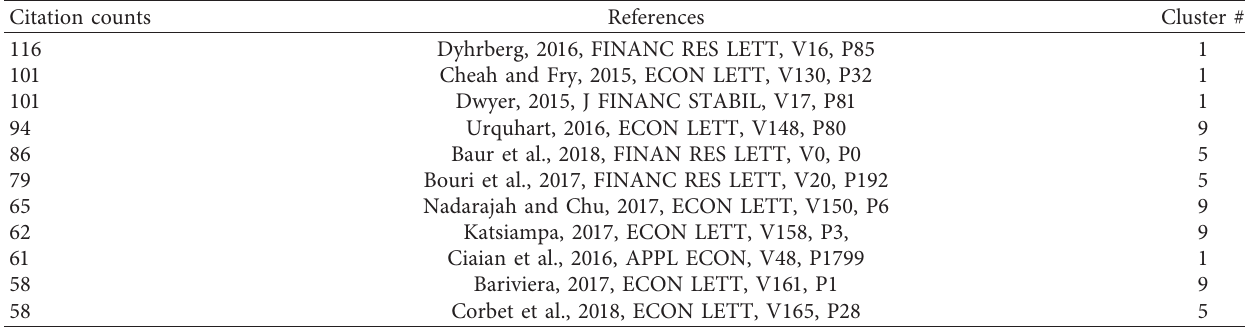
Table 2: Most cited references.